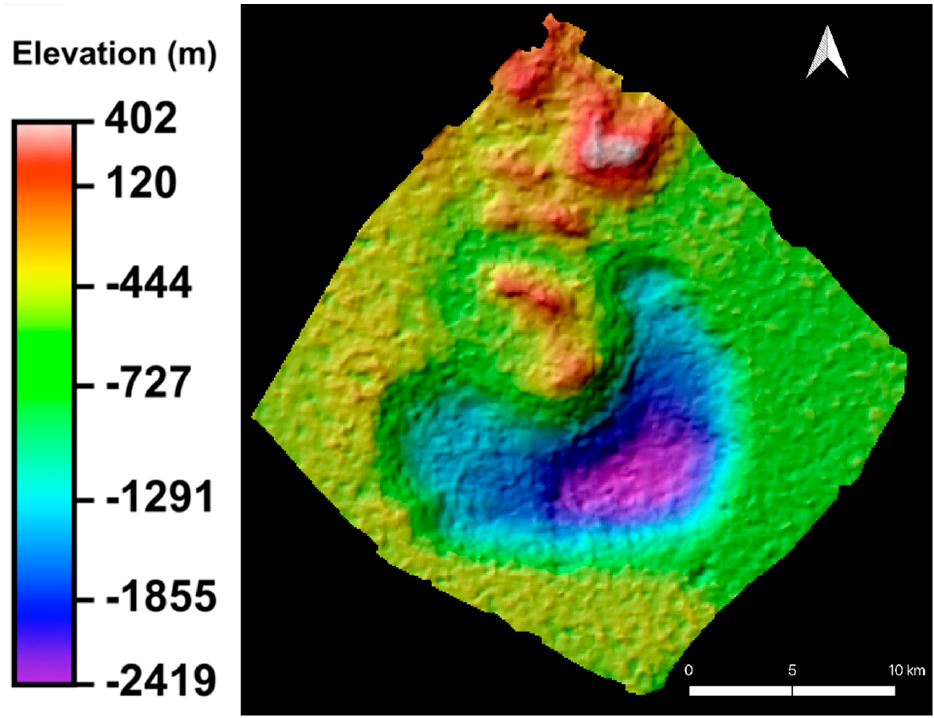
Figure A1. Vent in Catullus Crater.